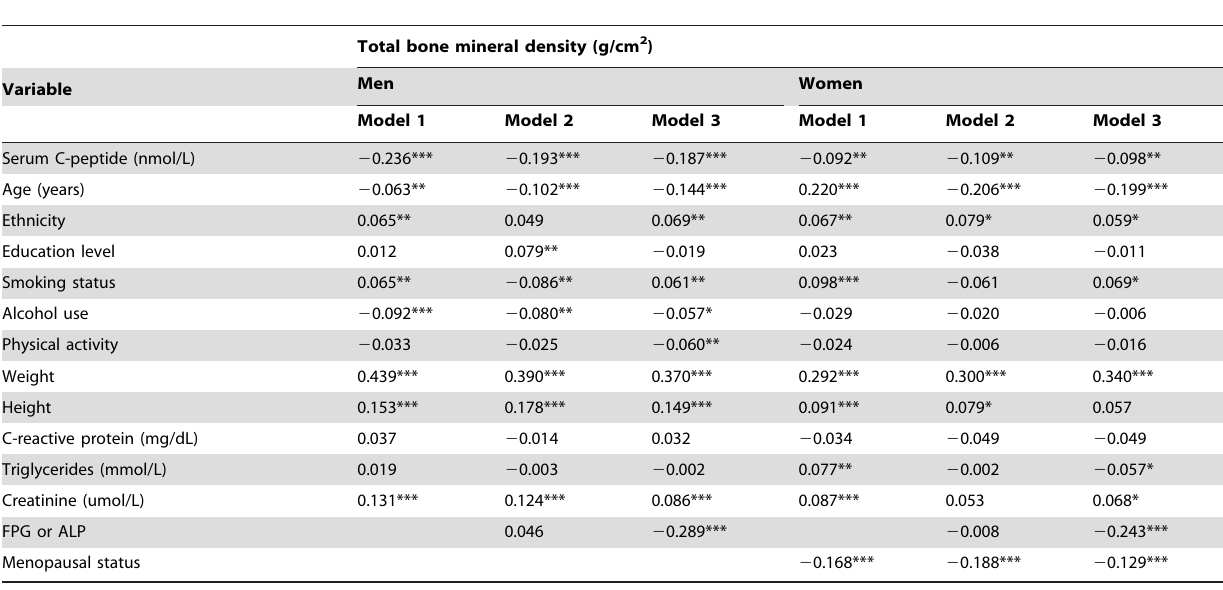
Table 2. The standardized regression coefficients of serum C-peptide level for total body bone mineral density from multiple regression analysis stratified by